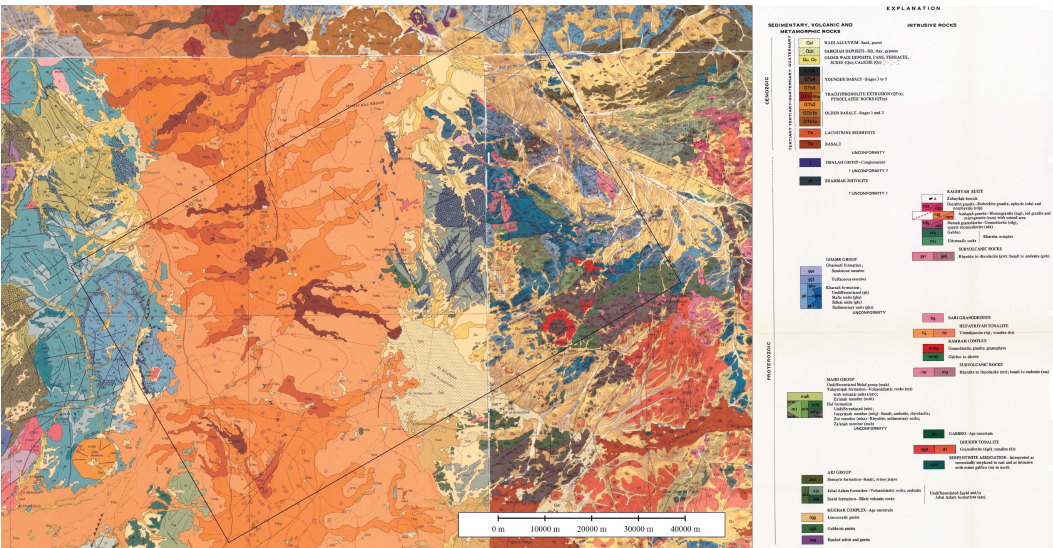
Figure 3. Geologic map of the survey area. The survey outline is shown as the black